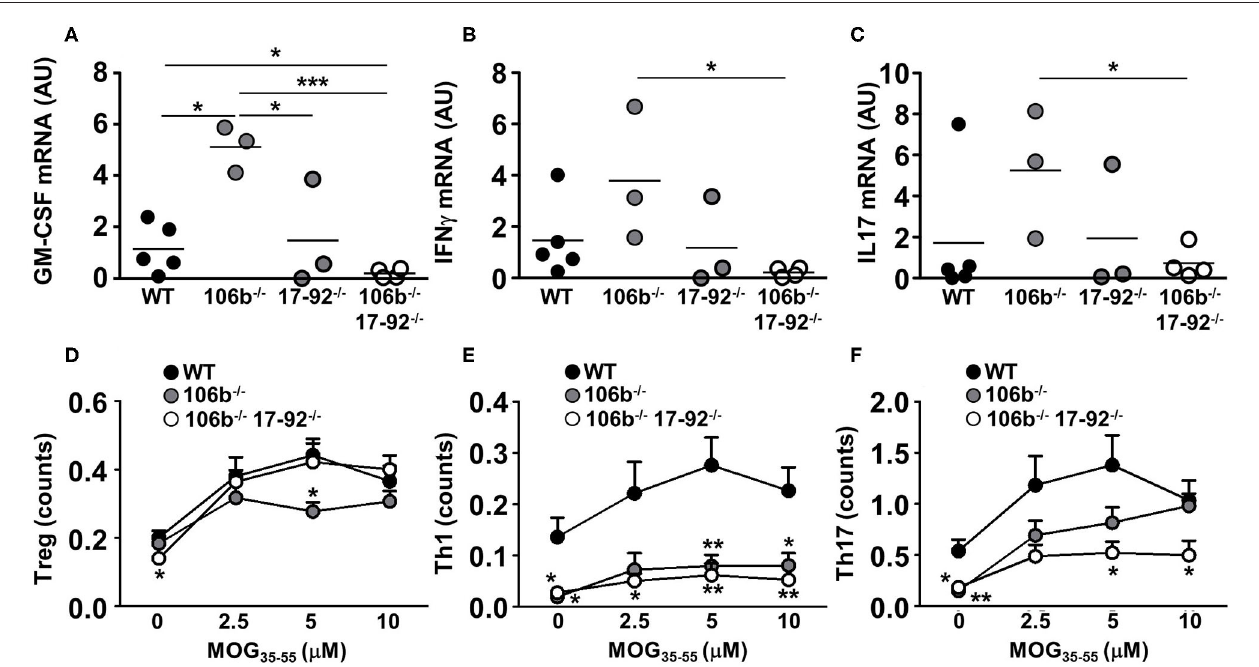
FIGURE 5 | Reduction of pro-inflammatory cytokines in mice lacking miR17-92 and miR106b. (A–C) mRNA levels of GM-CSF, IFN γ , and IL17 were measured in the spinal cord by real time RT-PCR. Data are shown as arbitrary units (AU). (D–F) Total splenocytes were isolated from mice spleen ( n = 5 for each group) 37 days after EAE induction. Cells were re-stimulated for 3 days with increasing amounts of MOG 35 − 55 and the absolute count of Treg, Th1, and Th17 cells (% singlets on 20,000 cells X % Treg or Th1 or Th17 on singlets/100) was measured by flow cytometry. Statistical significance was determined by Mann Whitney test. * P ≤ 0.05, ** P ≤ 0.01, and *** P ≤